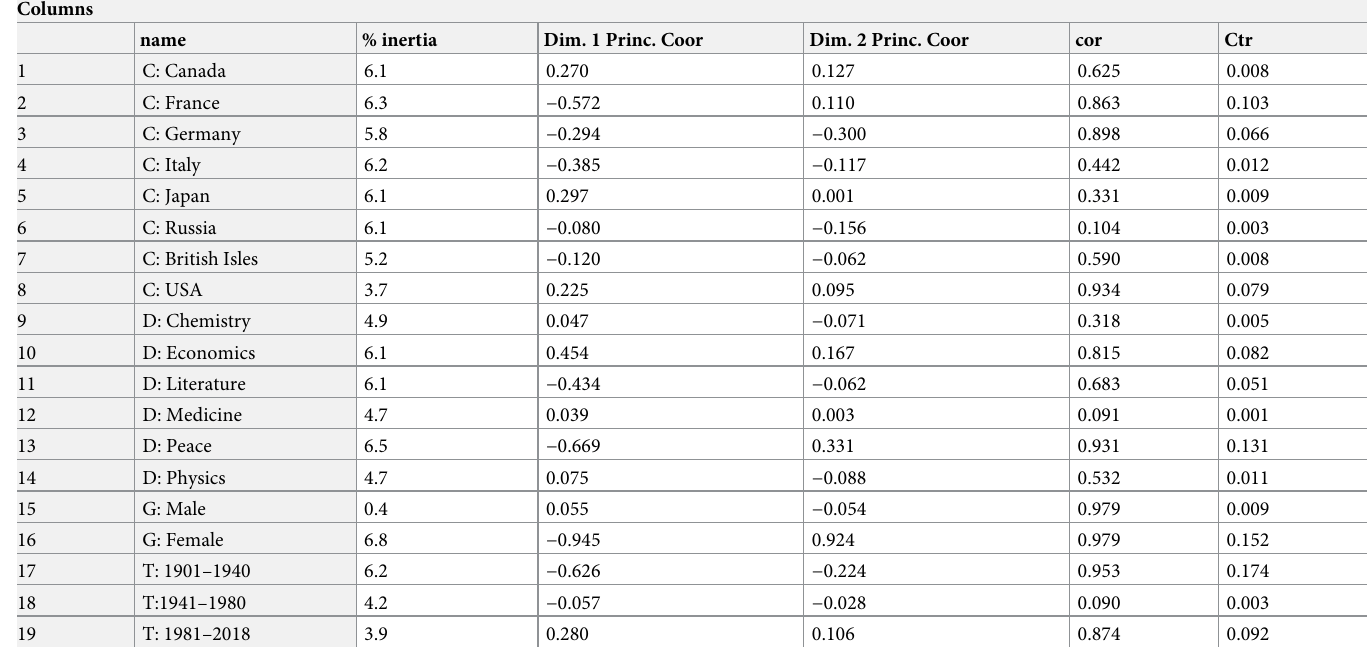
Table 2. Contribution of categorical variables to Fig 2 from joint correspondence